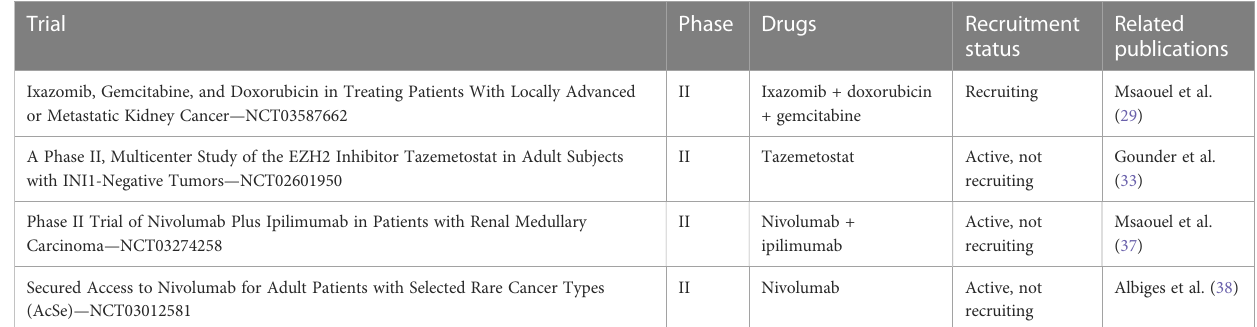
TABLE 1 Ongoing phase II trials for